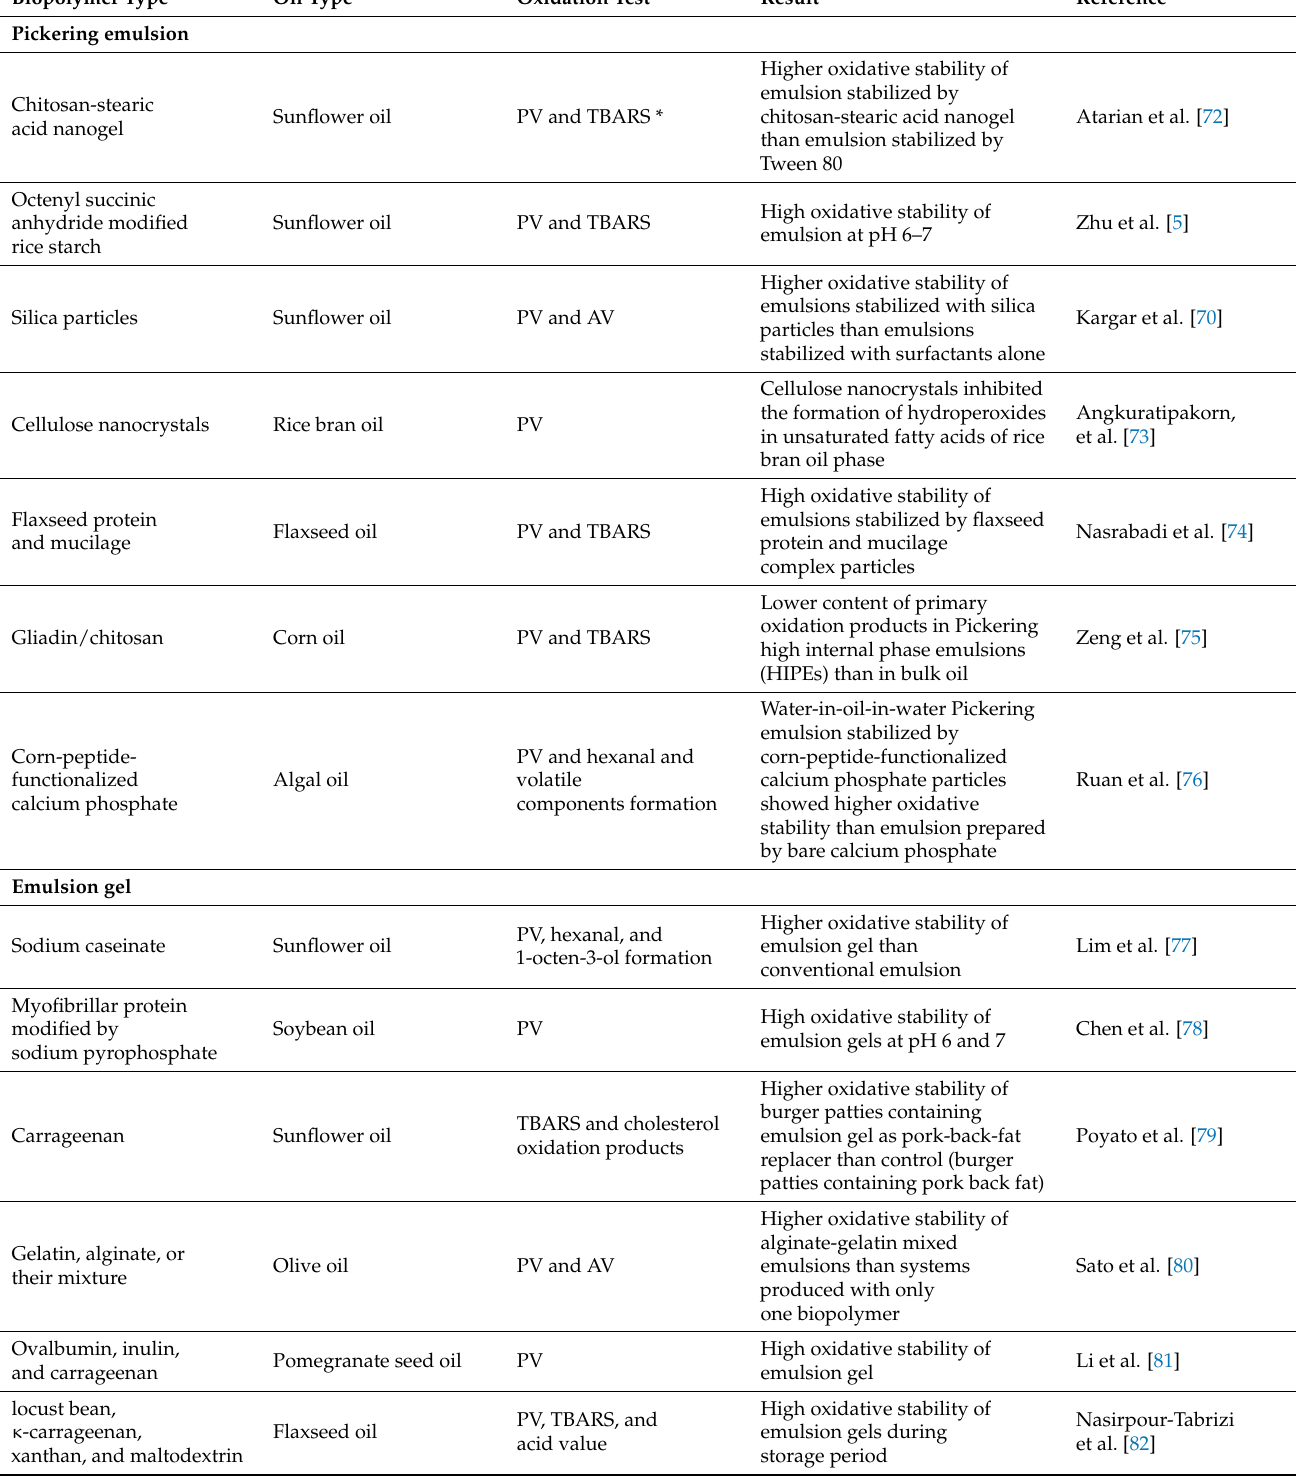
Table 3. Pickering emulsions and emulsion gels inhibited lipid oxidation at the interfacial